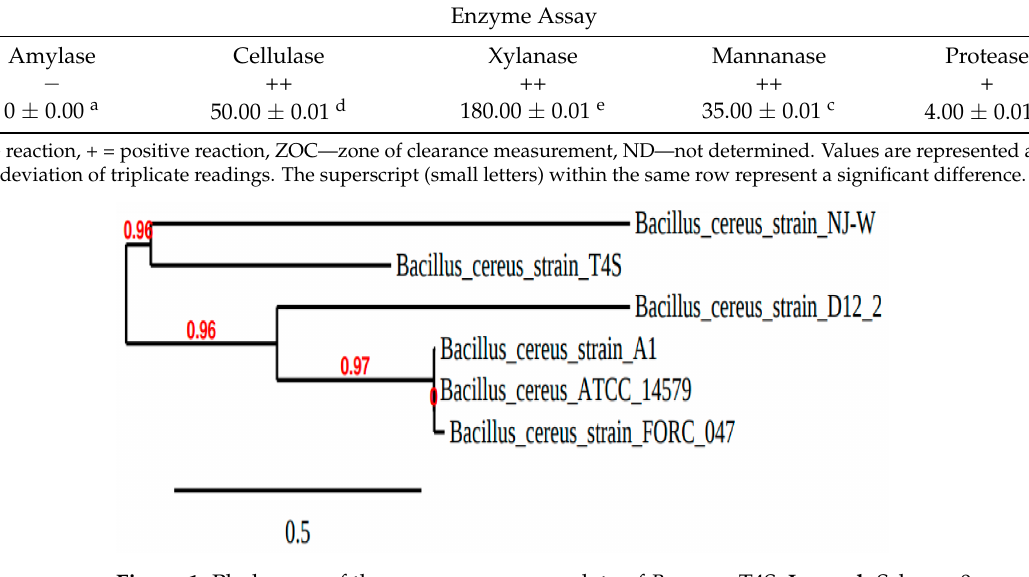
Figure 2. Circular genome visualization of the Bacillus cereus strain T4S. Each color from the external to internal circle depicts green (GC skew +), and red (ORF). The ring black coloration (GC content) at the peak indicated higher or lower values than average GC content. The GC Skew ( − /+) in purple/green peaks in/outside the circle indicated values greater or smaller than 1. The GC Skew is calculated as G − C/G +